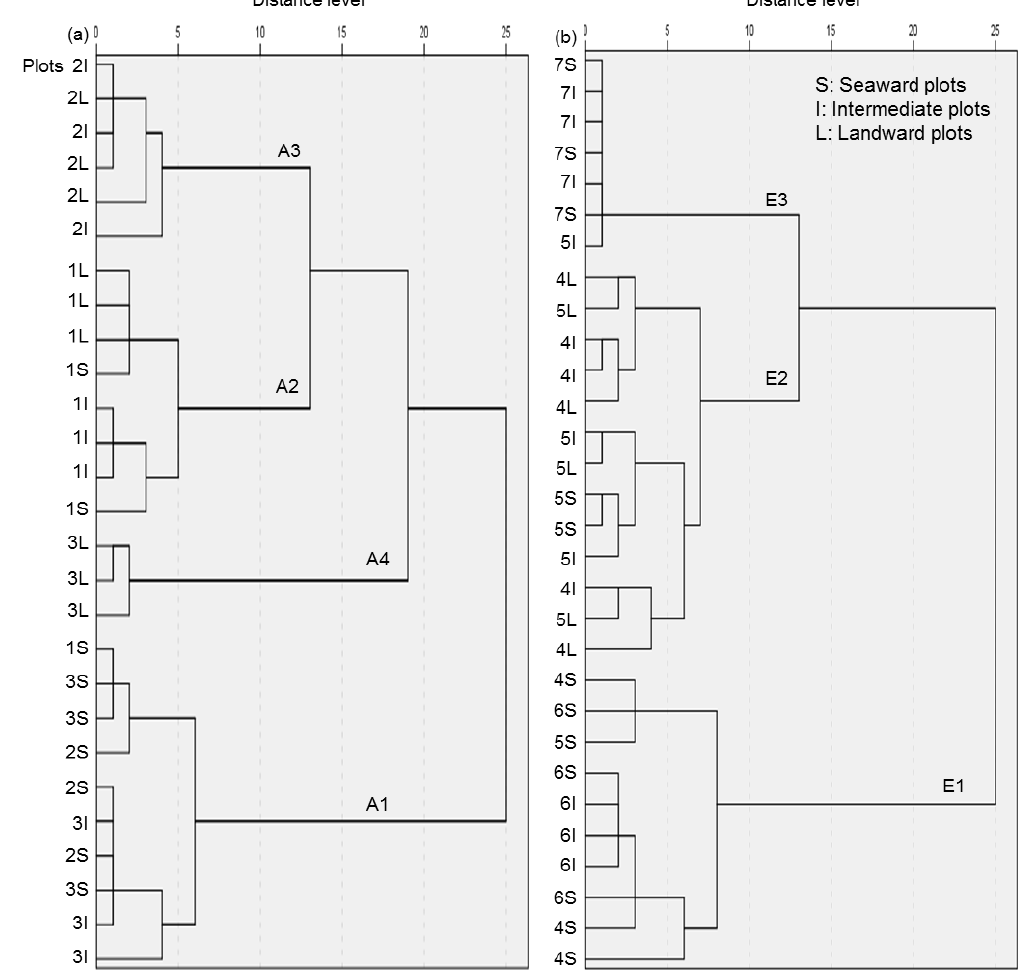
Figure 2. Hierarchical cluster analysis using Ward method, Euclidean distance, and Amalgamation steps as similarity measurements for ( a ) 27 plots in accretion sites (sites 1, 2 and 3) and ( b ) 30 plots in erosion sites (sites 4, 5, 6 and 7). Variables are shown in Table 2. Numbers in plots indicate site; Each site included 3 plots as seaward, intermediate and landward plots except in site 7; S indicates seaward plots, I intermediate, and L landward plots. A1, A2, A3, and A4 are groups for accretion sites and E1, E2, and E3 are groups for erosion sites.